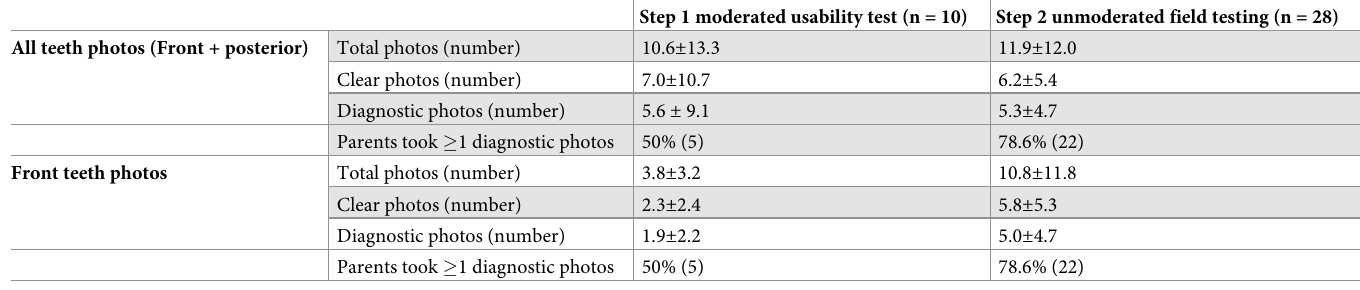
Table 2. Intraoral photos taken by participants.